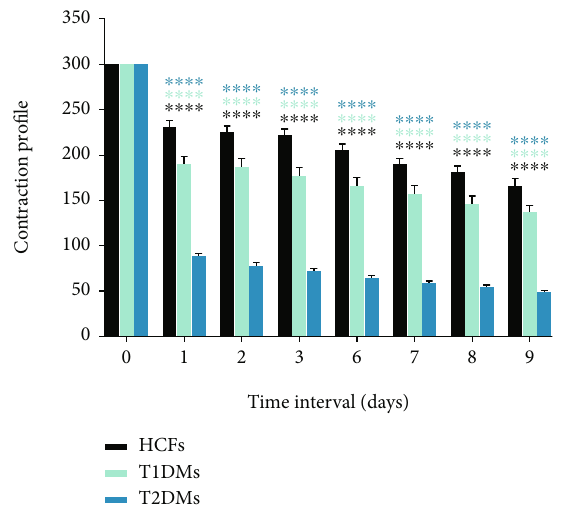
Figure 1: Quanti fi cation of contraction collagen matrix in HCFs, T1DMs, and T2DMs from days 0 to 9. A signi fi cant reduction is observed in the area of the collagen matrix between the three cell types correlating with increased contractility. Two-way ANOVA ( n = 12 ) was used to analyze the results. Error bars represent standard deviation ( ∗∗∗∗ denotes p < 0 : 0001